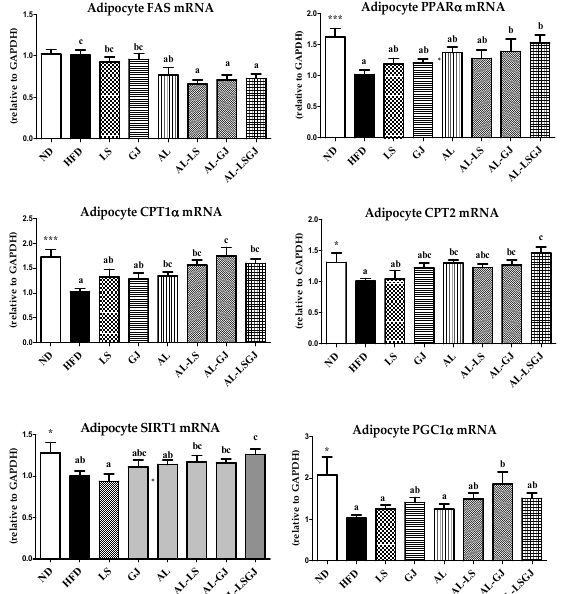
Figure 4. Effect of synbiotic supplementation for 12 weeks on epididymal adipose tissue gene expressions in diet-induced obese mice. Data are mean ± S.E.; Significant differences ND versus HFD are indicated; * p < 0.05, *** p < 0.001; abc Means with different superscript letters are significantly different among the groups ( p < 0.05); ND: normal diet (5% fat, w/w ); HFD: high fat diet (20% fat, 1% cholesterol, w/w ); LS: HFD + Lactobacillus sakei LS03 10 9 cfu/day; GJ: HFD + Leuconostoc kimchi GJ2 10 9 cfu/day; AL: HFD + 3% allulose; AL-LS: AL + Lactobacillus sakei LS03 10 9 cfu/day; AL-GJ: AL + Leuconostoc kimchi GJ2 10 9 cfu/day; AL-LSGJ: AL + Lactobacillus sakei LS03 + L. Leuconostoc kimchi GJ2 10 9 cfu/each/day; PPAR α : peroxisome proliferator-activated receptor alpha; SIRT1: sirtuin 1; PGC1 α : proliferator-activated receptor gamma coactivator